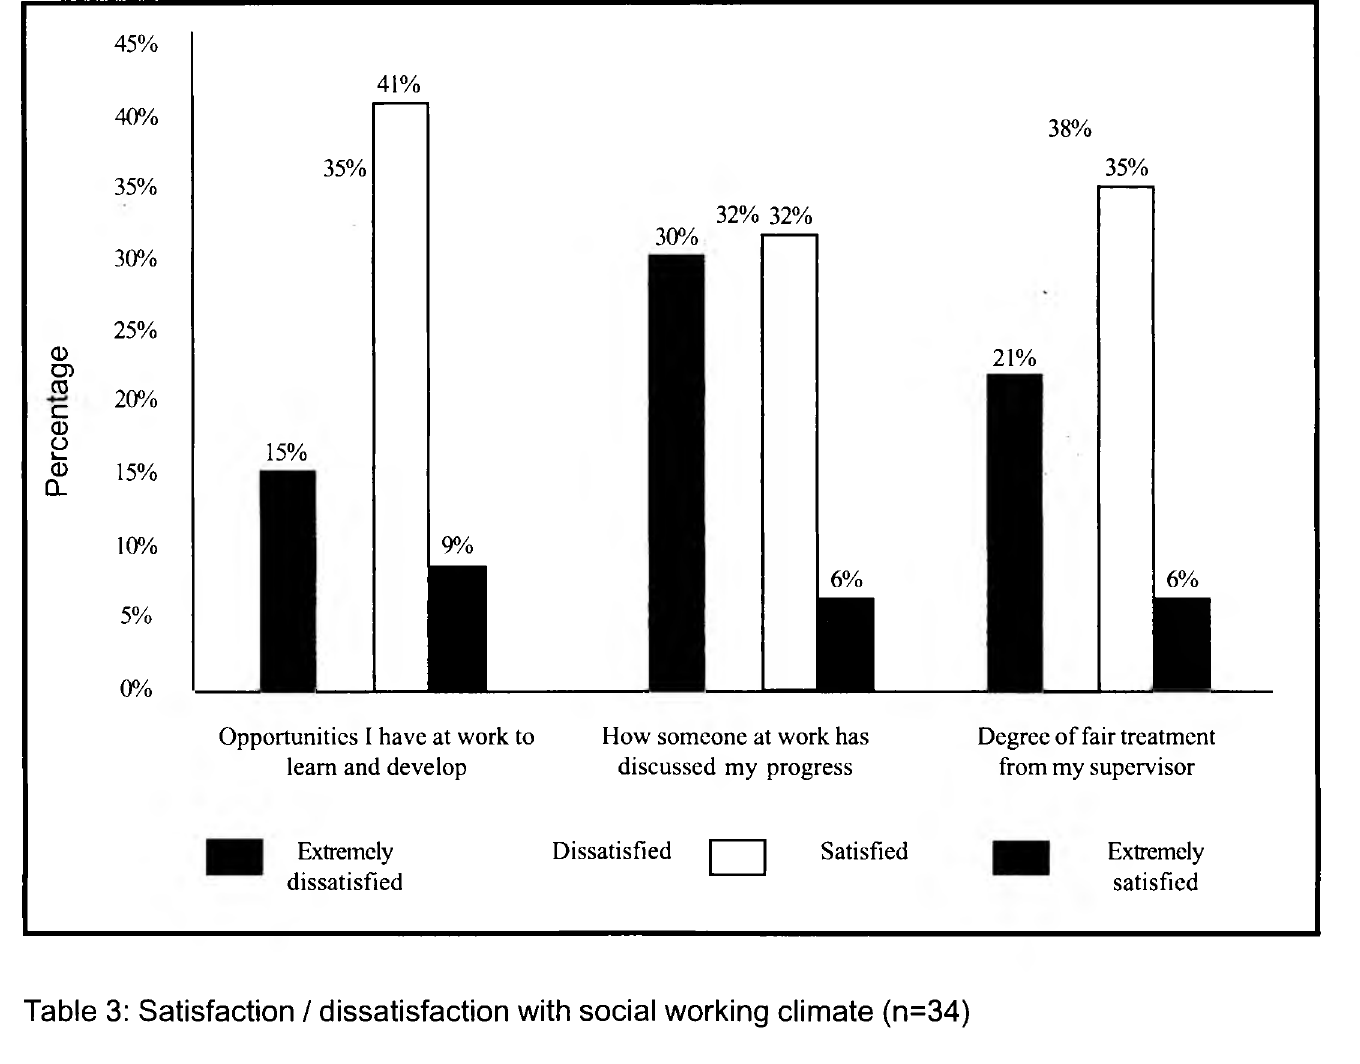
Table 3: Satisfaction / dissatisfaction with social working climate (n=34) ASPECTS OF SOCIAL